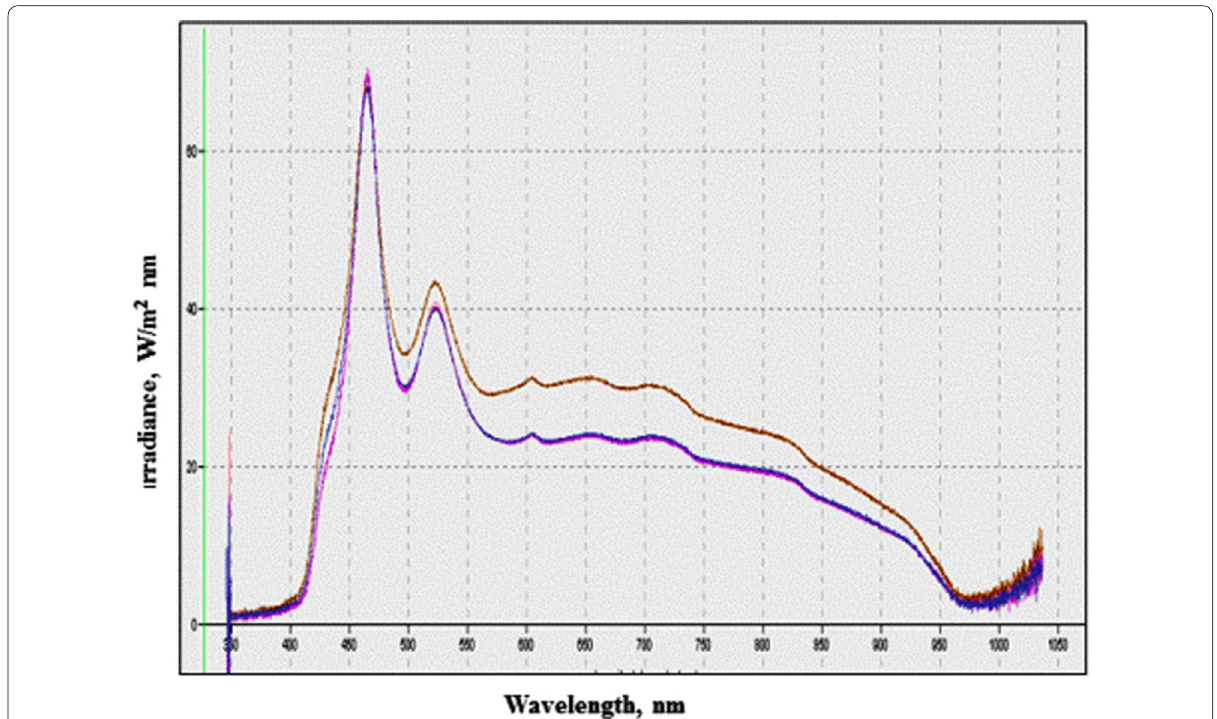
Fig. 2 Complete simulator spectrum (red), compared with the solar spectrum in Quito, Ecuador